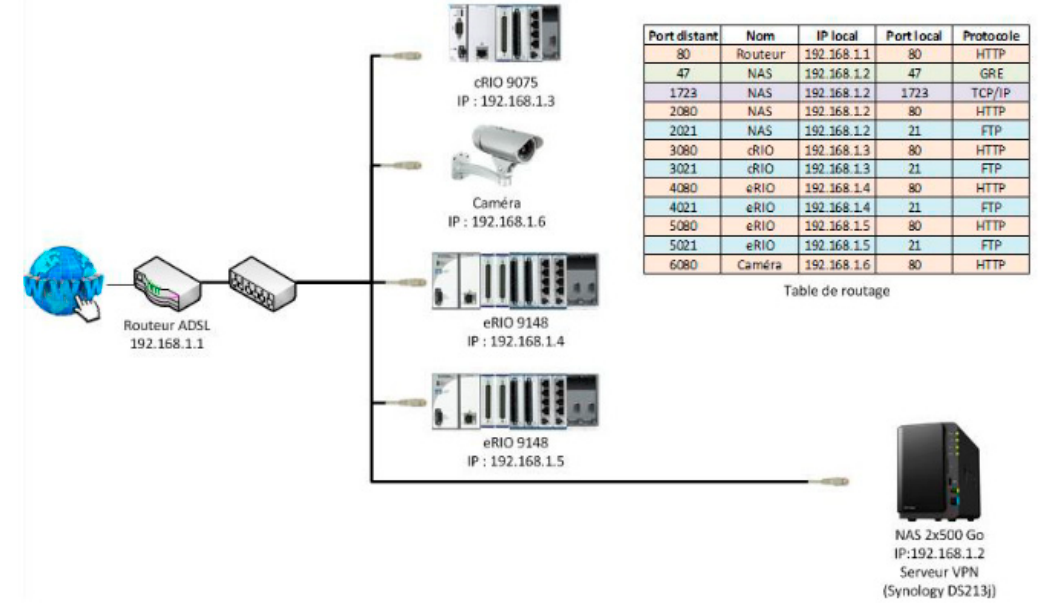
Figure 13. Architecture of the data acquisition system of SMARTVIA ® (figure is reproduced from Pouteau et al. [42]).